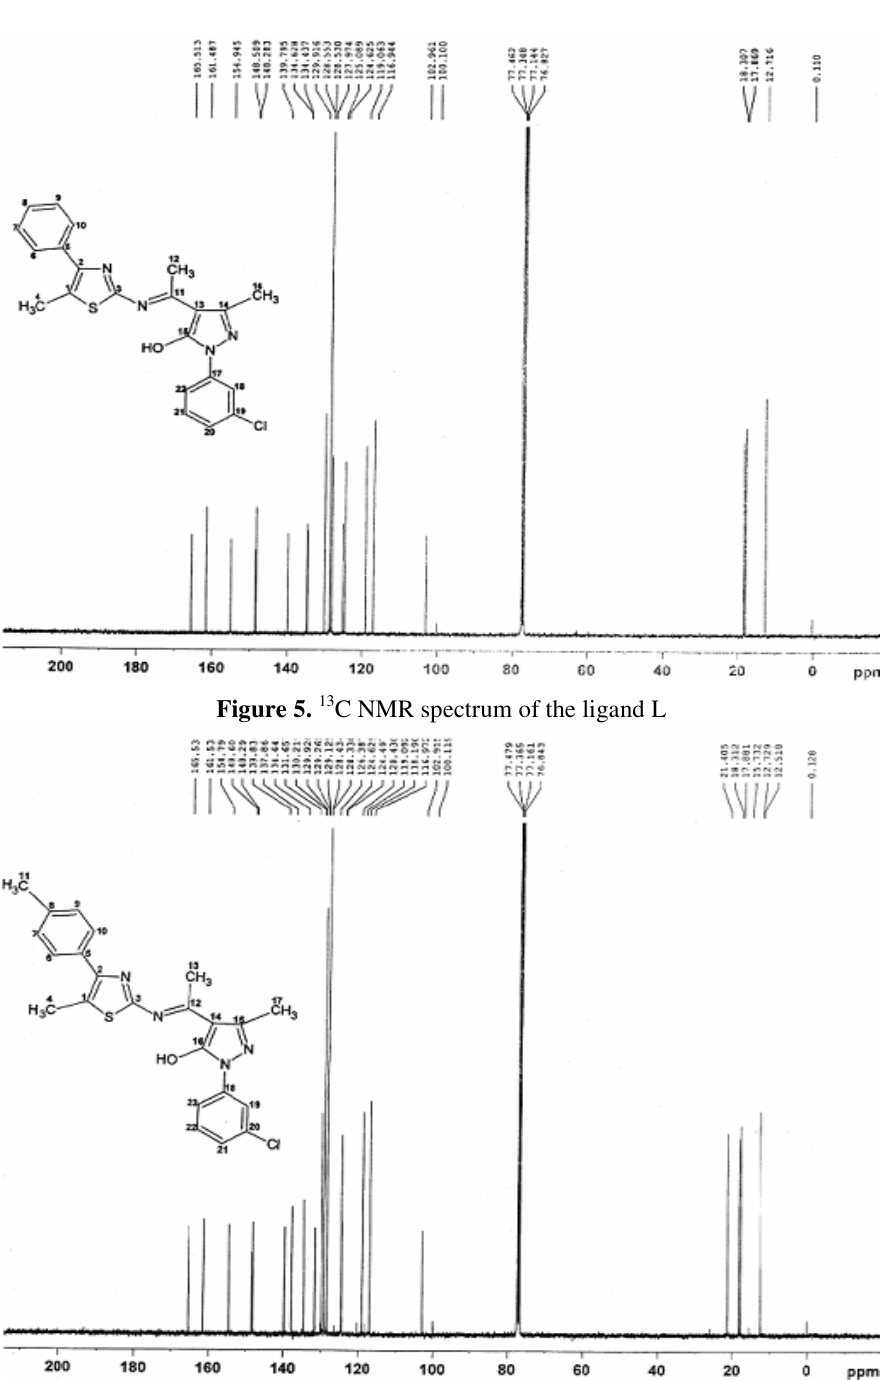
Figure 5. 13 C NMR spectrum of the ligand L